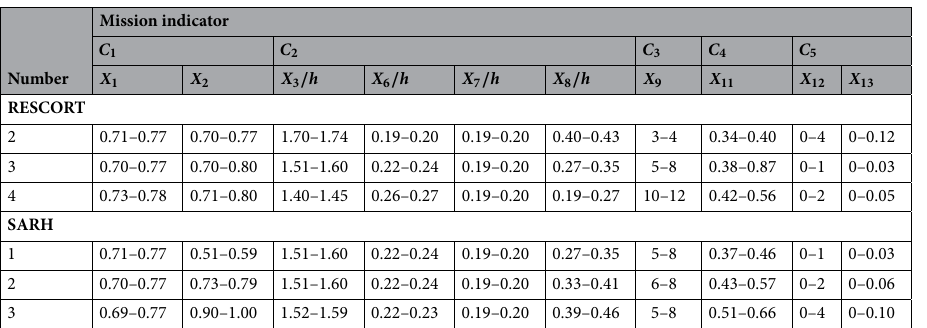
Table 5. Indicators X 1 ∼ X 13 and their value ranges. X 1 -success ratio of detection, X 2 -success ratio of rescue, X 3 -time spent from receiving the distress alert to dispatching, X 6 -time taken to reach the location of the target to be rescued, X 7 -time spent on rescuing the target, X 8 -time taken to return to base, X 9 -number of enemy personnel killed, X 11 -probability of being detected by the enemy, X 12 -number of casualties on our side, X 13 -rate of casualties on our